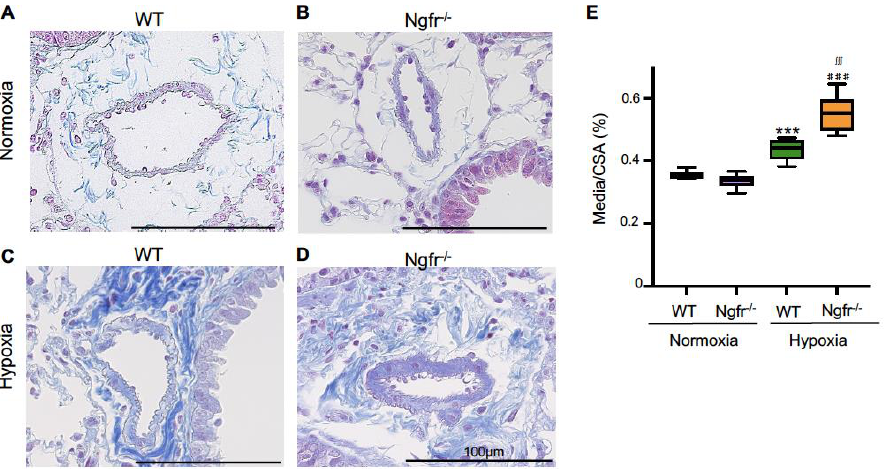
Figure 3. Histological analysis in pulmonary arterioles of WT and Ngfr −/− mice under normoxic and hypoxic conditions. Azan staining was performed to assess pulmonary vascular remodeling in WT and Ngfr −/− mice under hypoxic conditions. Azan staining of lung tissue in ( A ) WT Normoxia, ( B ) Ngfr −/− Normoxia, ( C ) WT Hypoxia, and ( D ) Ngfr −/− Hypoxia. ( E ) The ratio of the media to CSA (media/CSA) of WT and Ngfr −/− mice under normoxic and hypoxic conditions. CSA, cross-sectional area. Center lines show the medians, box limits indicate the 25th and 75th percentiles, whiskers extend 1.5× the interquartile range from the 25th and 75th percentiles. *** p <0.001 versus WT Normoxia. ### p < 0.001 versus Ngfr −/− Normoxia. ∫∫∫ p < 0.001 versus WT Hypoxia.